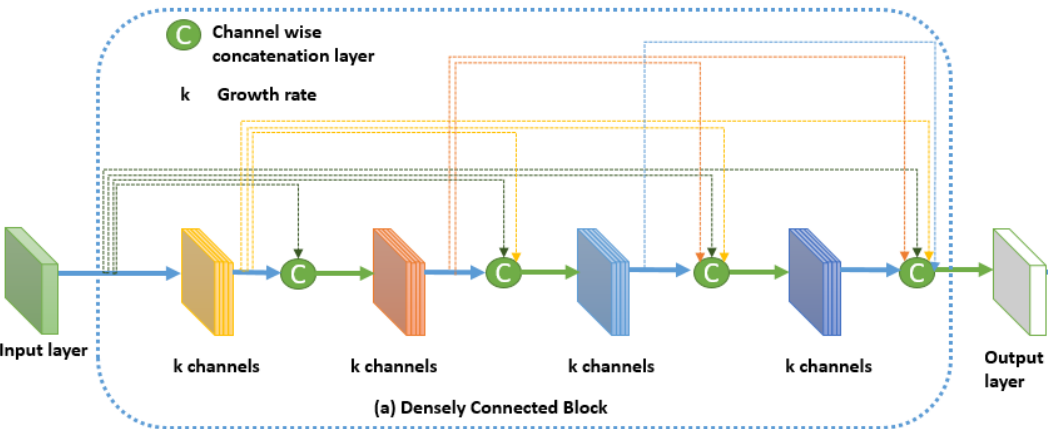
Figure 6. Dense block in DenseNet